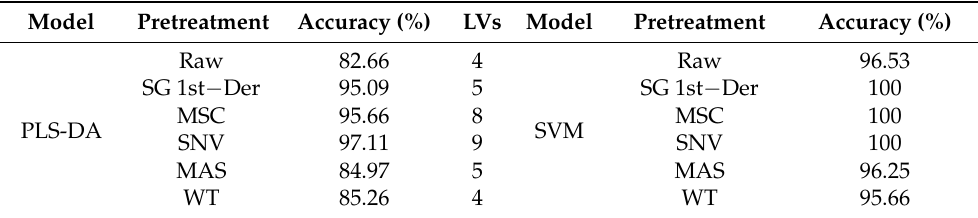
Table 1. The discrimination results of PLS-DA and SVM models’ training sets under different preprocessing